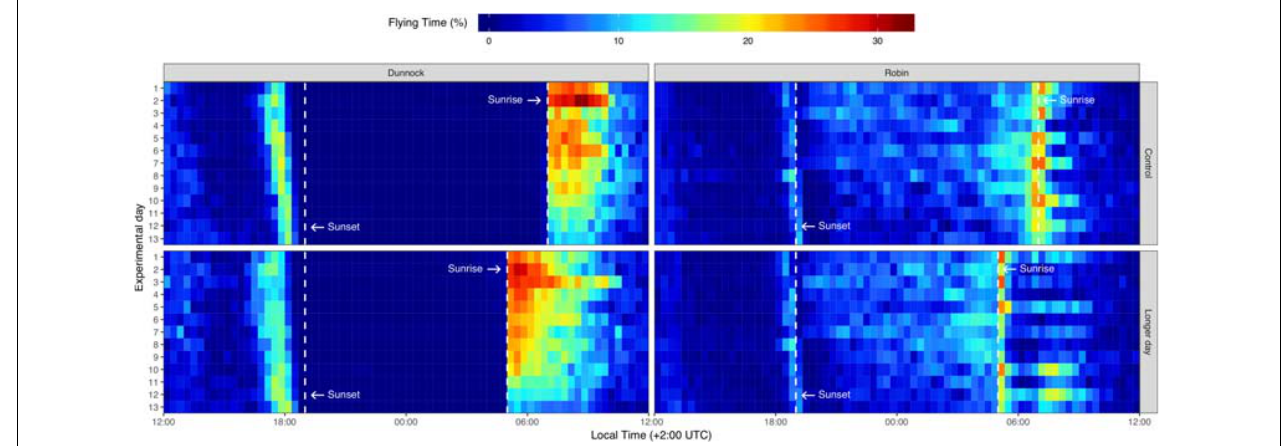
FIGURE 1 | Actogram of first-year migratory dunnocks ( Prunella modularis ) and European robins ( Erithacus rubecula ) monitored under local daylength timing (Control), and experimentally 2 h advanced early sunrise (Longer day). Each color-coded horizontal line shows the mean time spent in flying mode by 12 birds per group ( n = 24 for each species) from 12:00 of each day to 12:00 of the successive day. Dashed vertical lines indicate the time of sunset (19:00 for all groups), as well as sunrise at local time (07:00 for the Control groups) and 2 h earlier (05:00 for the Longer day